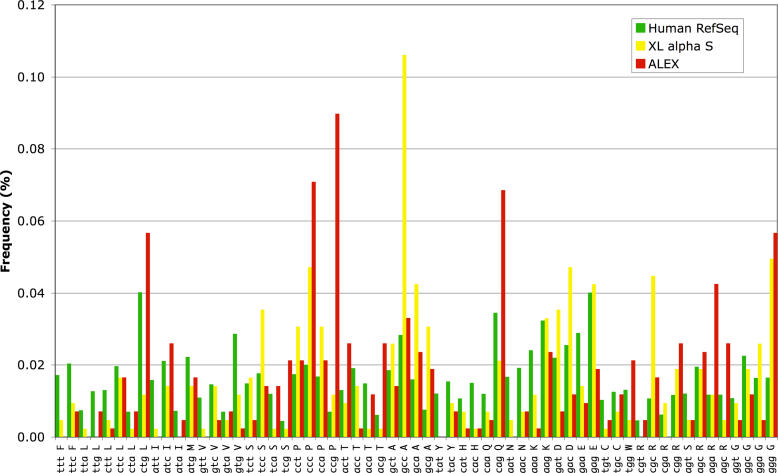
Codon Usage Estimated from Human RefSeq Genes, XLαs Coding Region, and ALEX Coding RegionGreen indicates human RefSeq genes, yellow indicates XLαs coding region, and red indicates ALEX coding region.